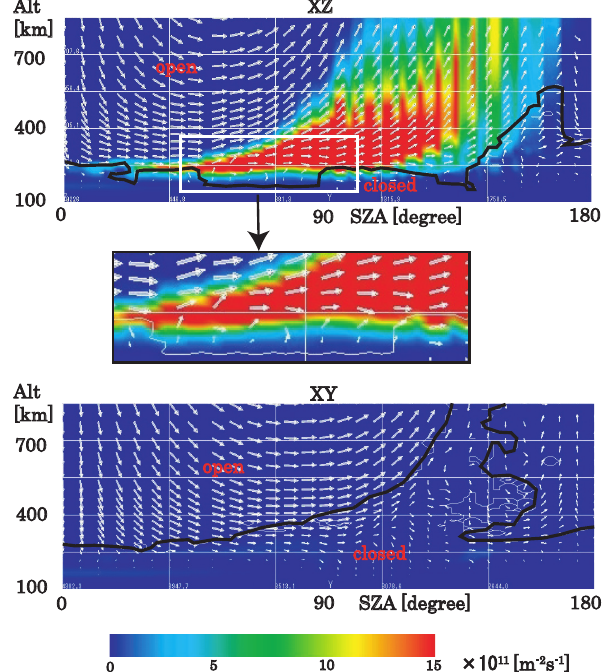
Fig. 9. Contour plots of the O + flux distribution. The horizontal axis 2 is in the solar zenith angle and the vertical axis is the altitude. Here we are focusing into the ionospheric altitude. The flow patterns are superposed by the white arrows. The top panel shows the meridian plane, and the bottom panel shows the equatorial plane. The label “open” (“closed”) indicates the region that is filled by open (closed) streamlines. The black lines in the top and the bottom panels are the demarcation lines between these two regions.